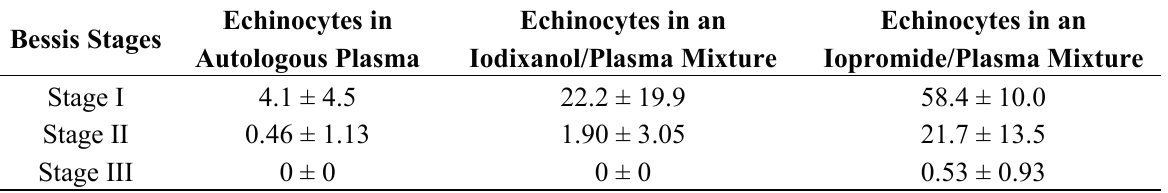
Table 1. Bessis stages in (%) of echinocytes suspended in autologous plasma, in an Iodixanol/plasma mixture (40% v / v ), and in an Iopromide/plasma mixture (40% v / v ).